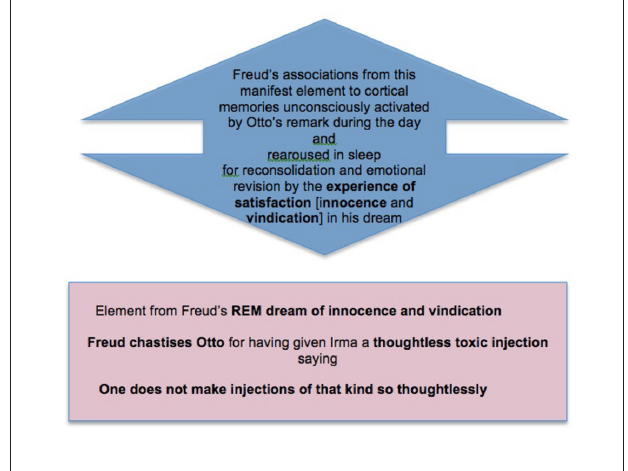
conflicted, and trauma-producing)